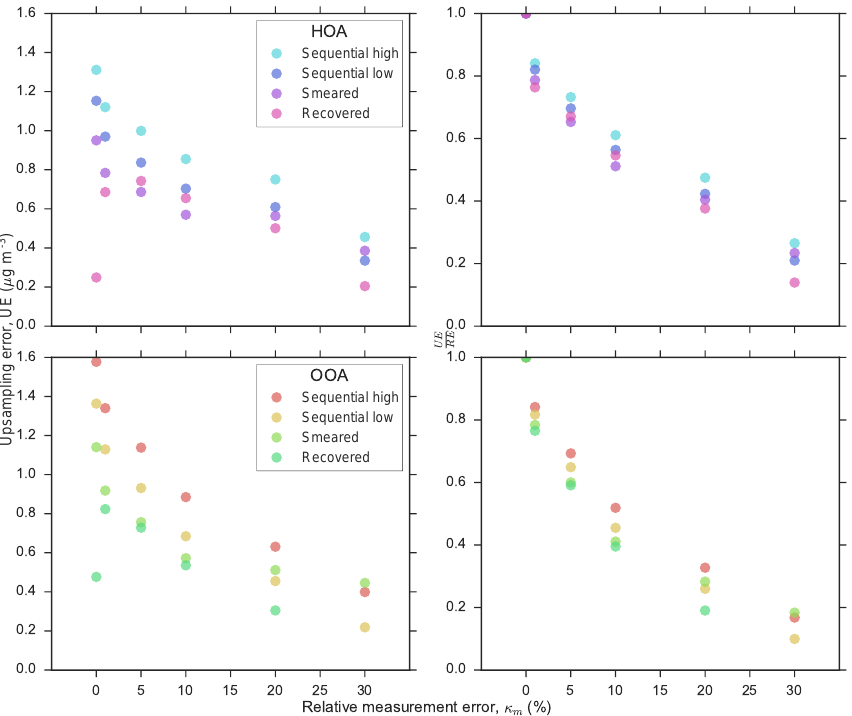
Figure 13. Left panels: upsampling error (UE) vs. κ m for HOA and OOA time series ( T = 57h) measured with 4h samples. Right panels: the corresponding UE fractions of the total error (RE) as a function of κ m